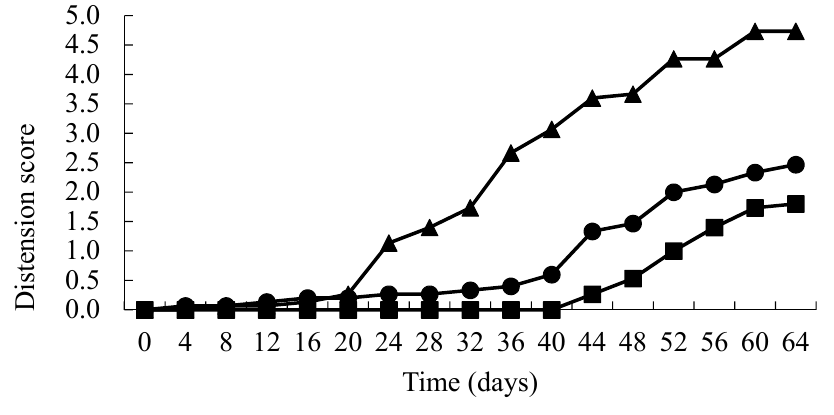
Figure 3. Distension status over time (days) of vacuum packs inoculated with spores of C. estertheticum and packaged in films containing 0 × MIC ( ▲ ), 2.5 × MIC ( ● ) and 3.5 × MIC ( ) SO.